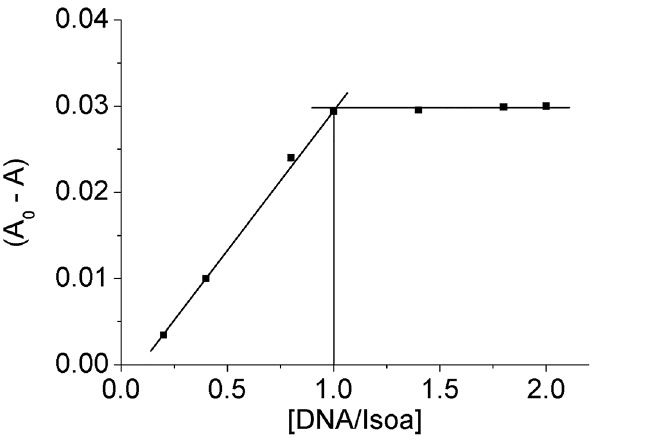
Fig 4. Binding stoichiometry. Mole ratio plot of Isoa-DNA system.